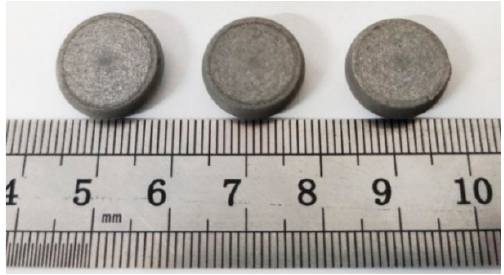
Figure 5. PTFE/Al/Si samples recovered from quasi-static compression test.